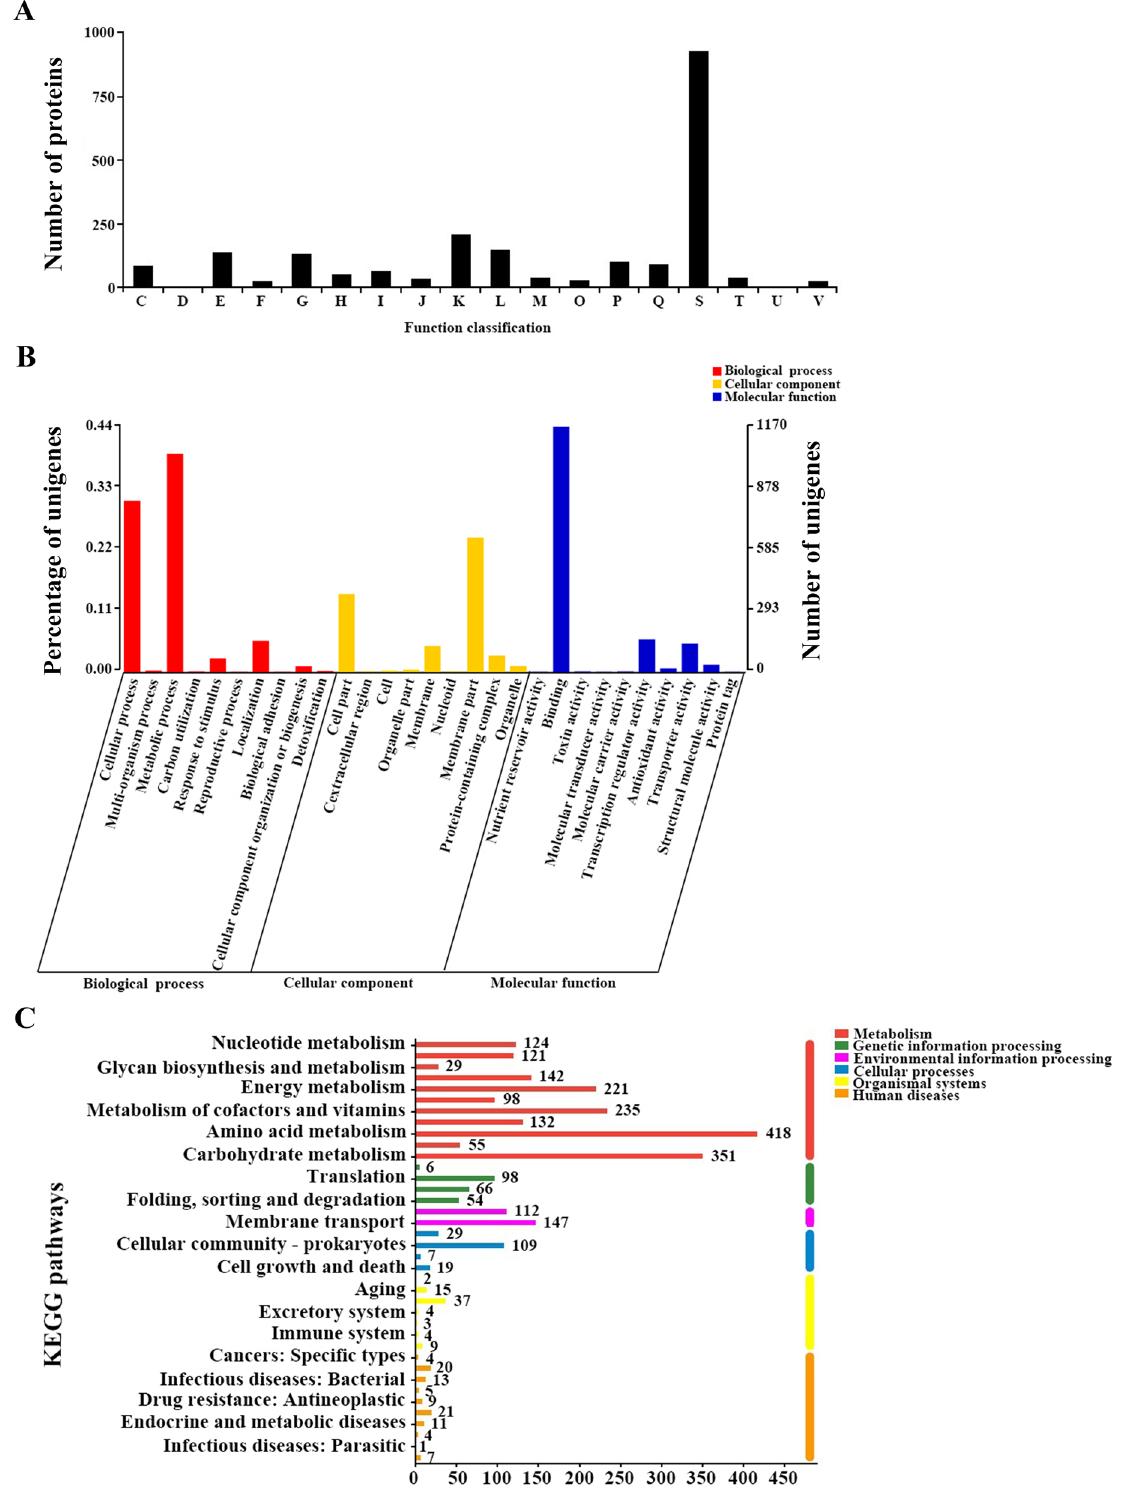
Figure 1. Annotations of the S. spinosa genome information using COG database, GO database and KEGG database. ( A ) Annotation of the S. spinosa genome sequence using COG database; ( B ) Annotation of the S. spinosa genome sequence using GO database; ( C ) Annotation of the S. spinosa genome sequence using KEGG database. (The chart was carried out using Majorbio Cloud Platform. URL: http:// www. major bio.